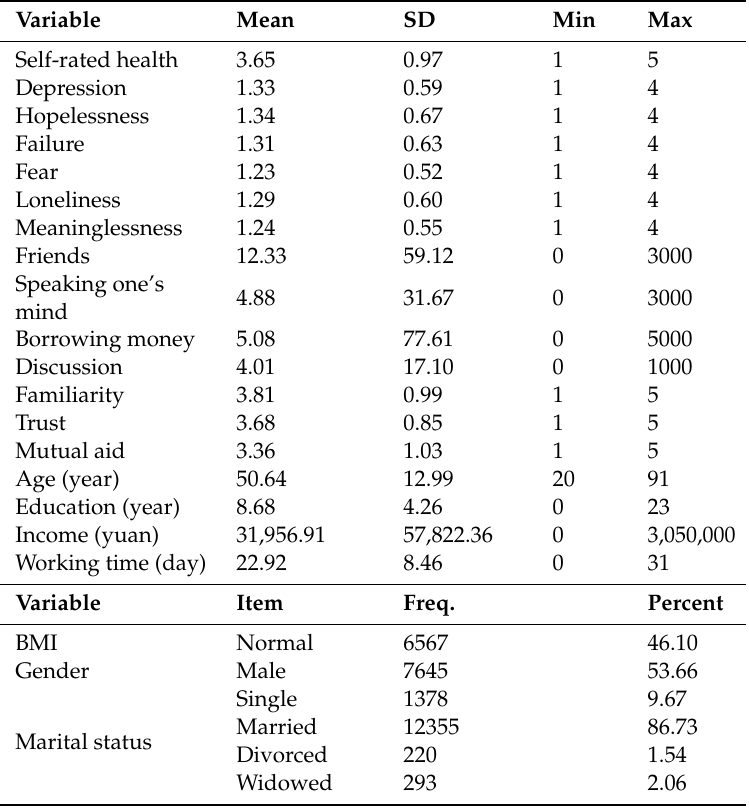
Table 1. Descriptive analysis ( N =